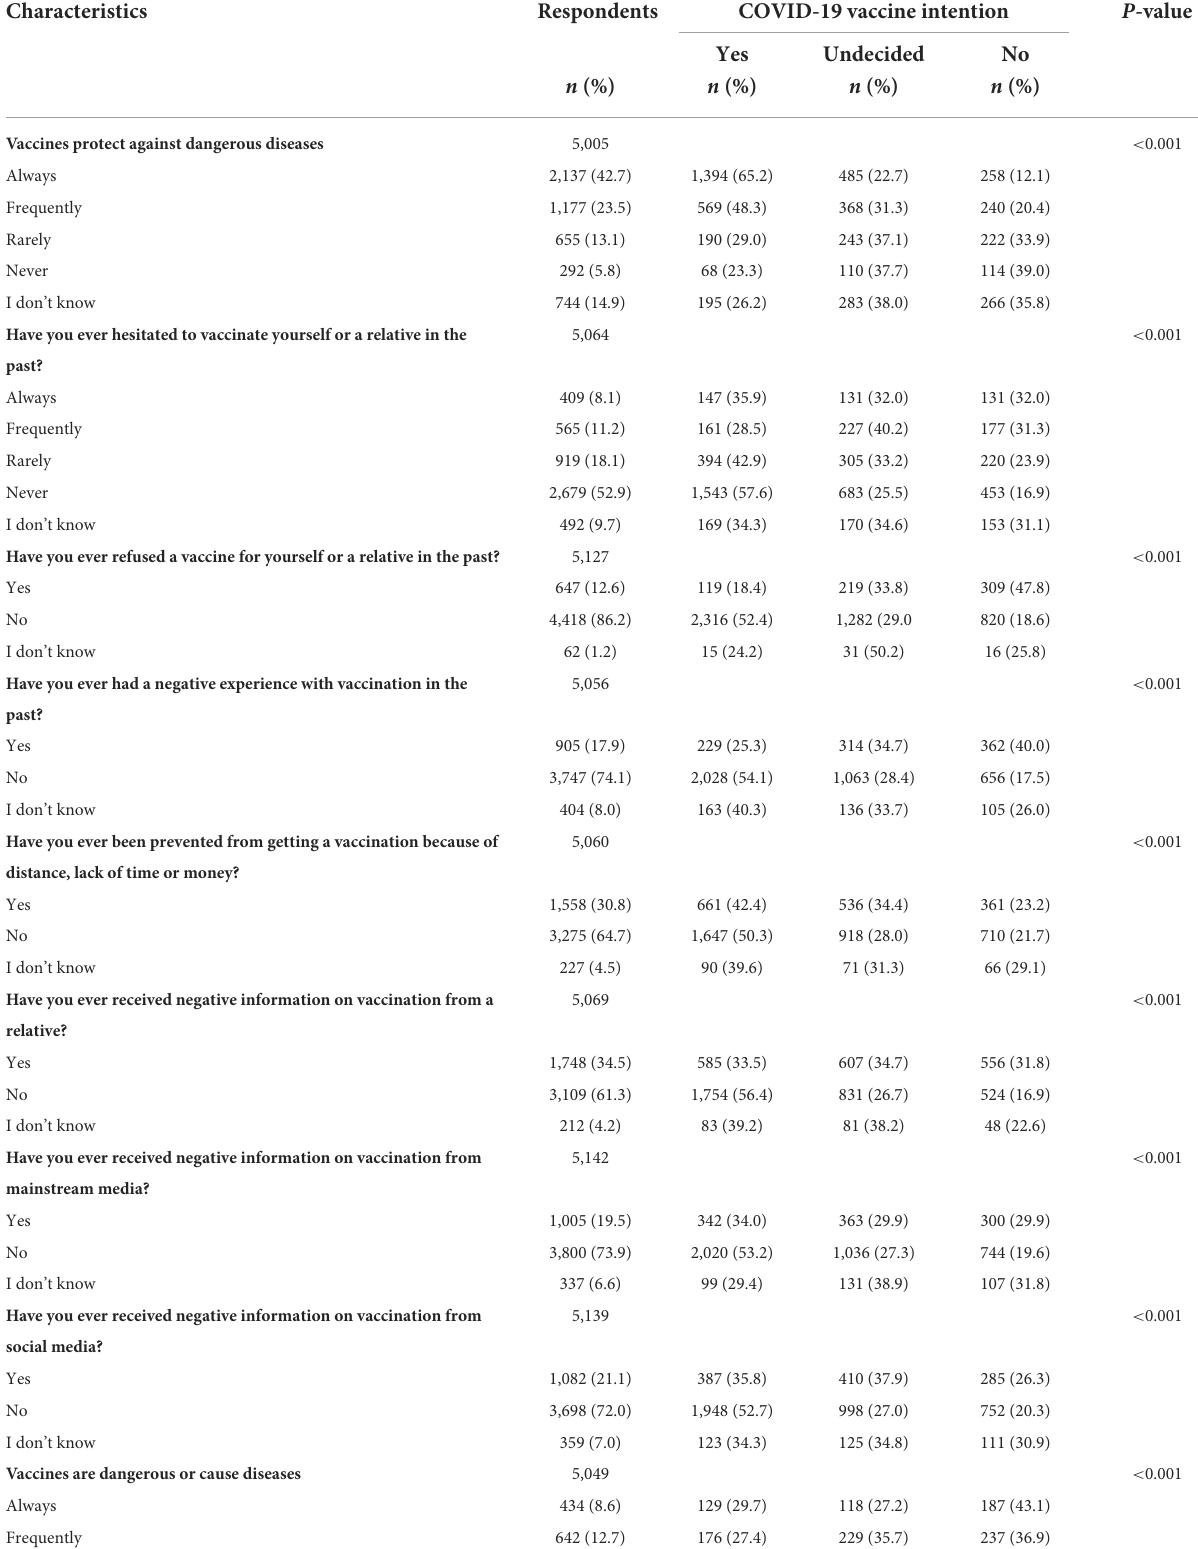
TABLE 3 Respondent’s beliefs/attitudes and association with COVID-19 vaccine intention.